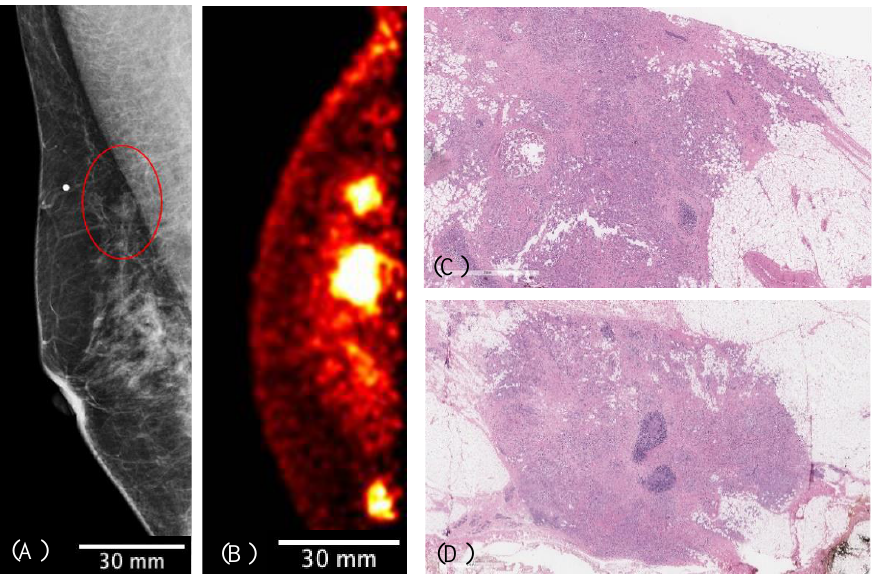
Figure 12. The MLO-view digital mammography image ( A ) demonstrates the palpable mass (red circle) associated with the radiopaque marker placed on the patient’s skin. The presented slice of Radialis PET Camera CC image with 200 MBq injected 18 F-FDG ( B ) identifies this lesion against the chest wall as well as two additional posterior masses. ( C ) View of the largest focus showing invasive ductal carcinoma of no special type; a clip-site reaction is present in the center of the tumor. ( D ) Second invasive focus demonstrating similar morphologic features and histologic grade. The 3 regions of contrast enhancement identified by Radialis PET are all biopsy-confirmed cancers.